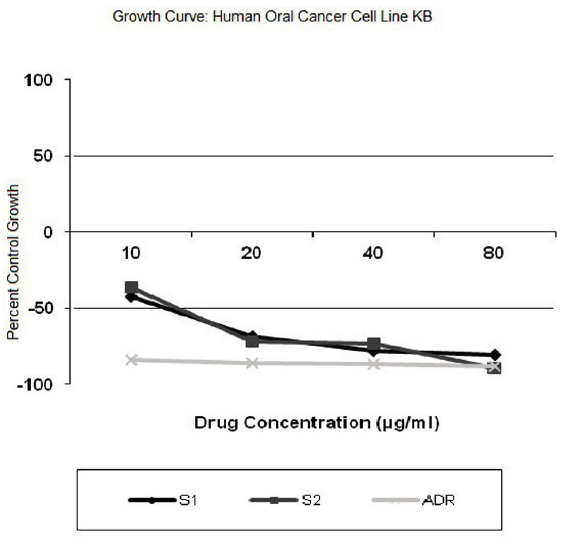
Figure 7. In vitro cytotoxicity profile of curcumin (S1), MSC Curcumin (S2), doxorubicin (ADR) in human cancer cell line